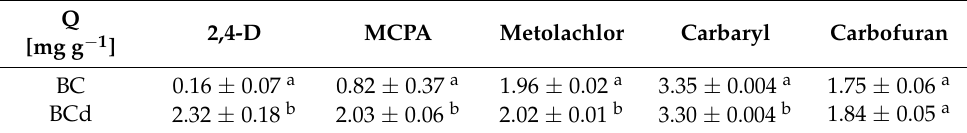
Table 5. Adsorption capacity (Q) of pristine (BC) and deashed biochar (BCd) towards the studied 2,4-D, MCPA, metolachlor, carbaryl and carbofuran pesticides. Results are expressed as mean values ± standard deviation ( n =